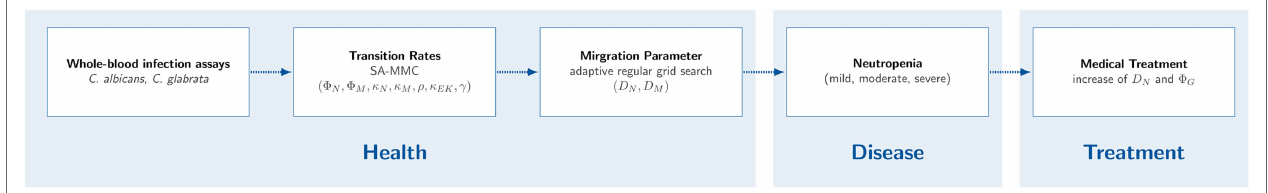
FIGURE 1 | Workflow for studying neutropenia in silico . First, whole-blood infection assays with Candida albicans and Candida glabrata were performed in wet lab. Second, non-spatial immune-reaction rates were fitted using the state-based model. Third, the agent-based model (ABM) was used to estimate migration parameters for neutrophils and monocytes. Based on the fitted non-spatial immune-reaction rates and the fitted migration parameters, virtual neutropenic patients were simulated in the ABM by gradually reducing the neutrophil count. Eventually, a medical treatment of the virtual patients was simulated by increasing the diffusion coefficient and/or the phagocytosis rate of